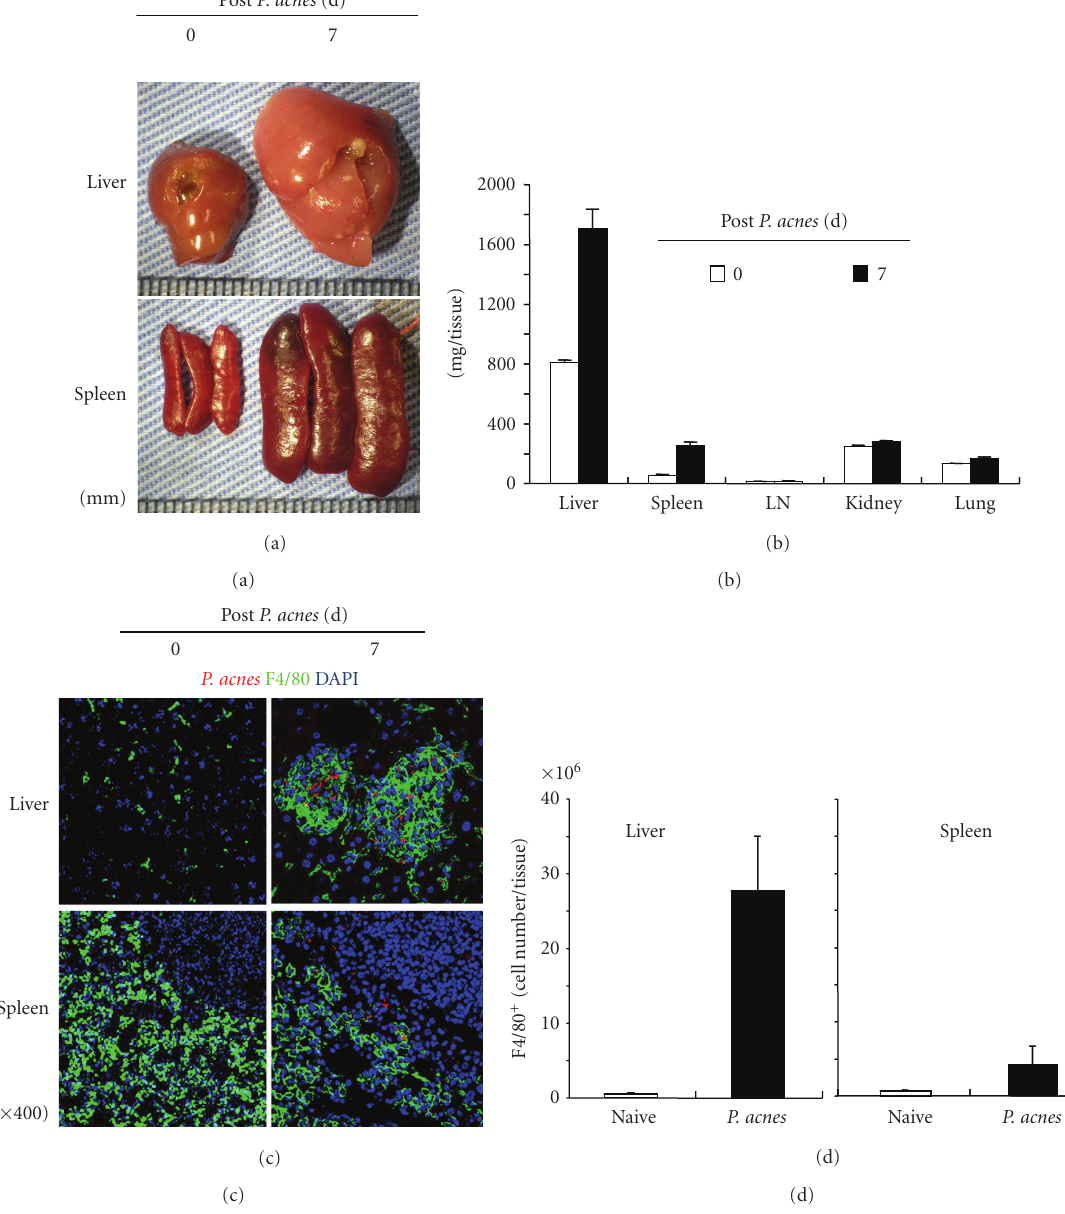
Figure 4: Hepatosplenomegaly and hepatic granulomas in P. acnes -primed mice. Wild-type mice received Cy3-labeled, heat-killed P. acnes , and at day 7 various tissues were removed and weighed (a, b). The liver slices were stained with anti-F4/80mAb and DAPI for detecting macrophages and cell nuclei, respectively (c). Kup ff er cells and splenocytes were prepared from P. acnes -primed (closed) or na¨ıve mice (open). After staining with anti-F4/80 mAb, proportion of F4 / 80 + cells were determined by FACS, and total F4 / 80 + cell number was